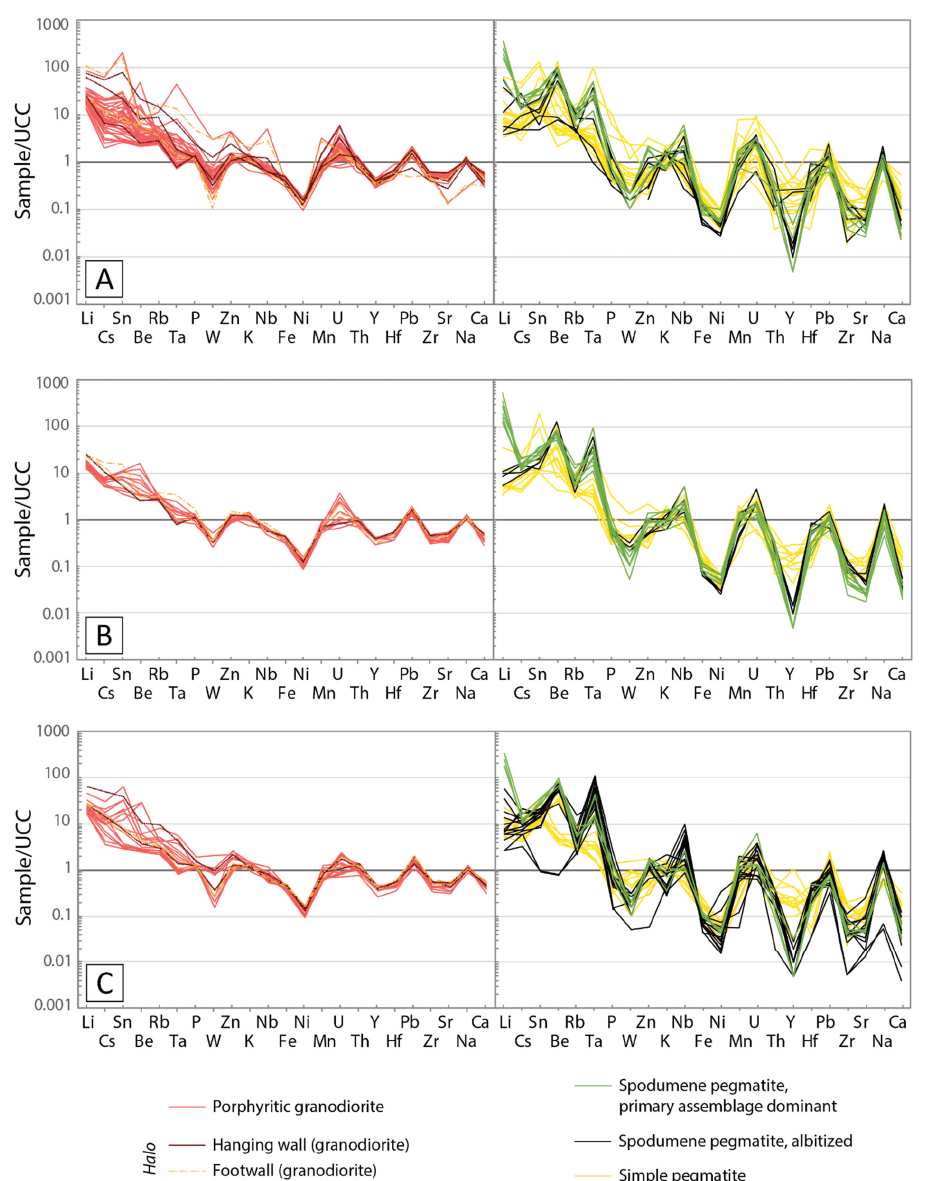
Figure 7. Whole-rock concentrations of elements of interest normalized against the upper continental crust (UCC; values from [34]) for the Moylisha drill cores ( A ) MOY 13-01, ( B ) MOY 13-02 and ( C ) MOY 13-03.